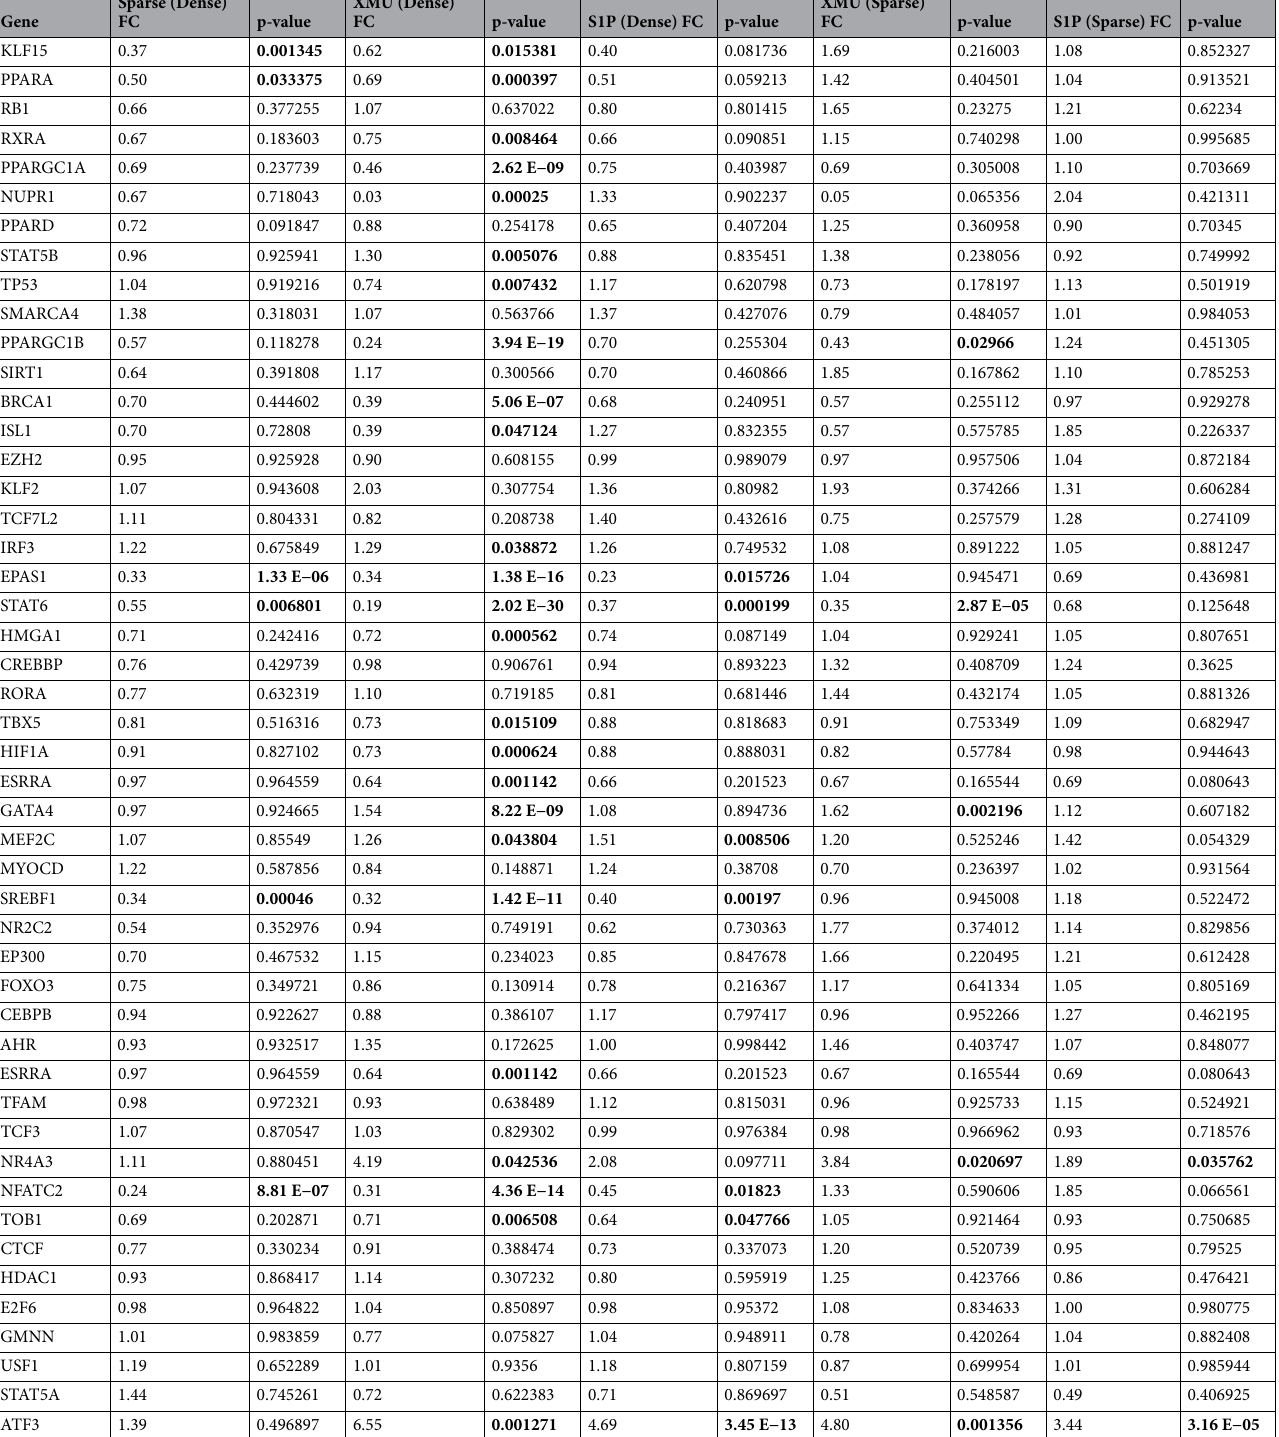
Table 2. Cardiomyocyte maturity genes. Bold values indicate significant